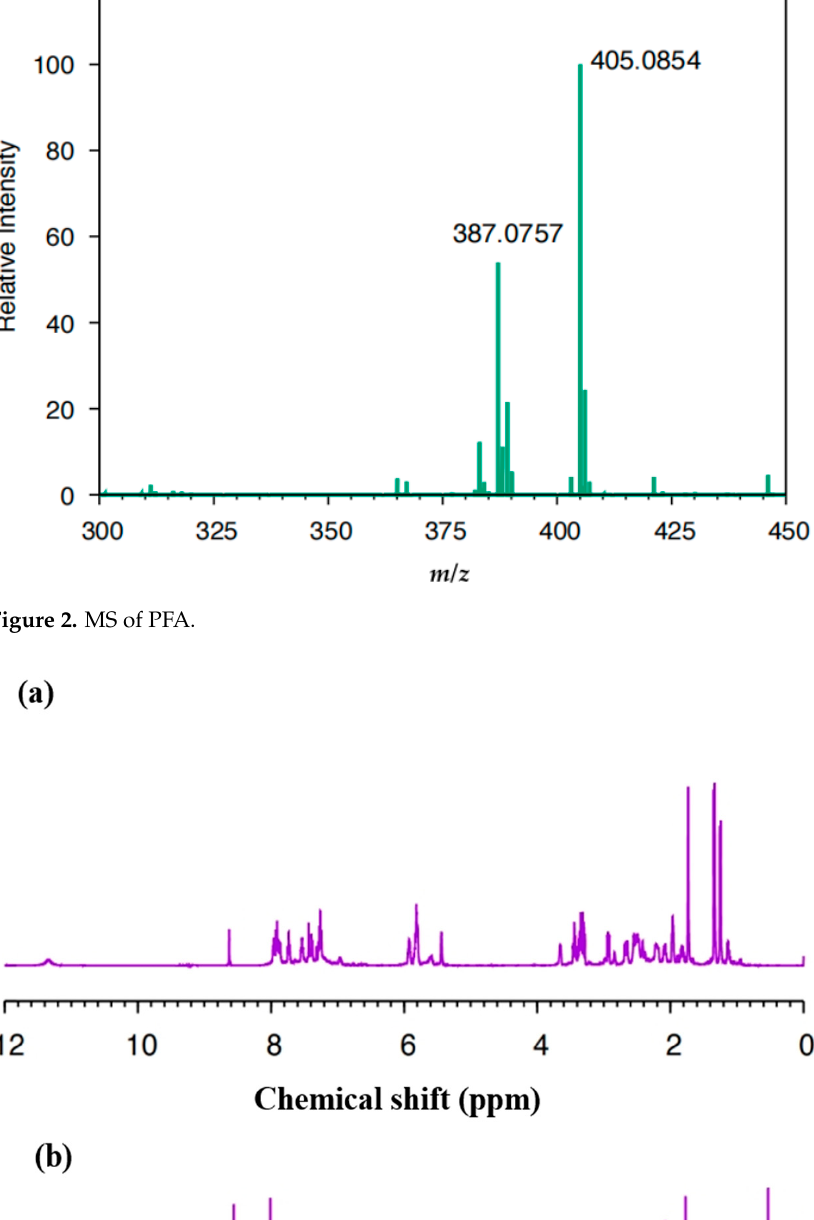
Figure 2. MS of PFA.